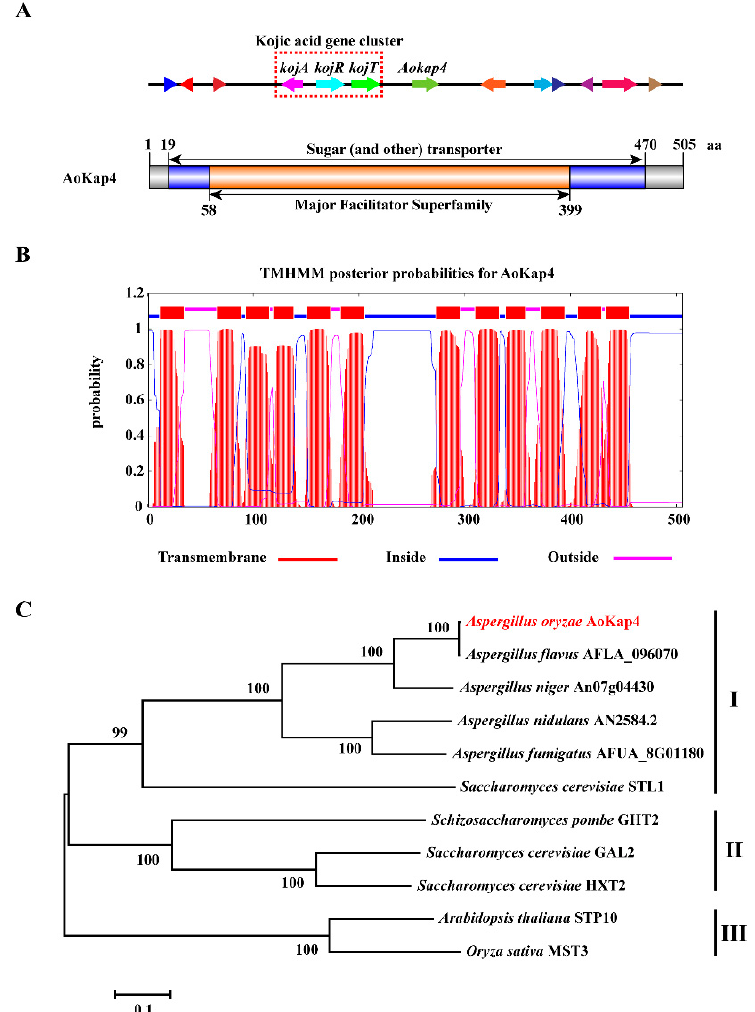
Figure 1. Sequence characterization and phylogenetic analysis of the AoKap4 protein. ( A ) The location of Aokap4 in the kojic acid gene cluster and the domain analysis of the AoKap4 protein. The Aokap4 gene adjacent to kojT within the kojic acid gene cluster encoded a major facilitator superfamily transporter. The kojic acid gene cluster is indicated in the red dashed box. ( B ) The analysis of transmembrane helices of the AoKap4 protein using the TMHMM Server. ( C ) Phylogenetic analysis of AoKap4 and its orthologs from fungi and plants. The phylogenetic tree was constructed using MEGA7 with 1000 bootstrap replicates and the neighbor-joining (NJ) method.